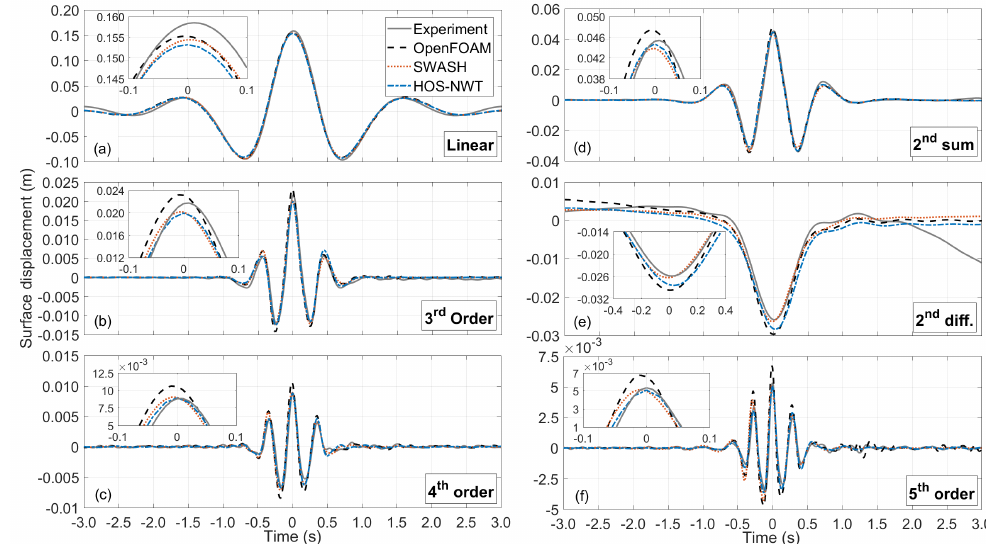
Figure 14. Comparison of the free surface elevation of the harmonics between the numerical models and the experiment at the PF location.